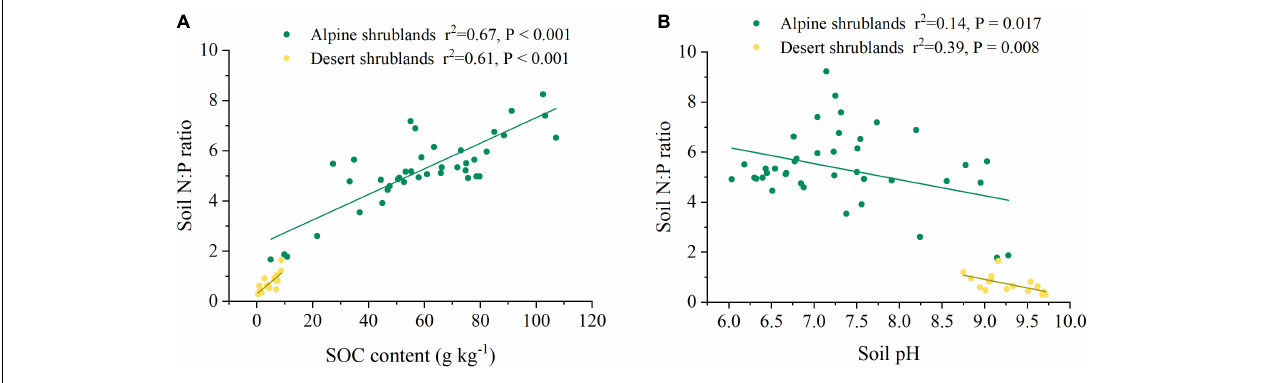
FIGURE 4 | The relationship among soil organic carbon (SOC) (A) , soil pH (B) , and soil N:P ratio. Yellow circles indicated desert shrublands, while green circles indicate alpine shrublands. TABLE 1 | Model results of multivariate regressions among soil nitrogen: phosphorus (N:P) ratio soil organic carbon (SOC) content, soil N content, and soil pH at 0–100 cm in the Tibetan Plateau shrublands.